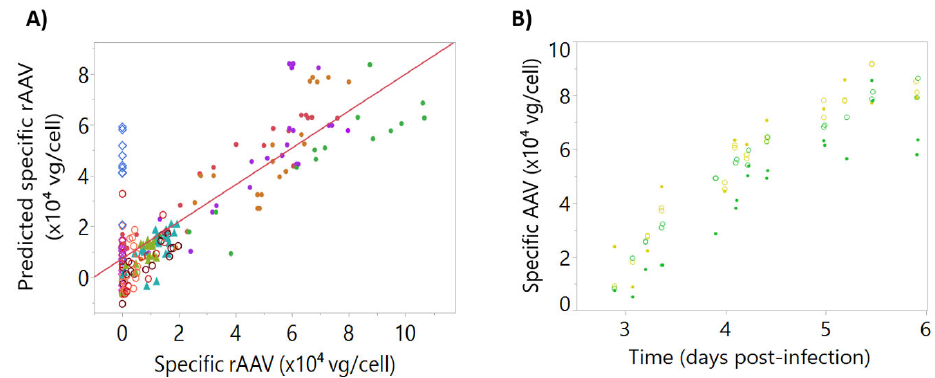
Figure 7. Calibration and testing data for intracellular specific recombinant adeno-associated virus (rAAV). Batches are represented by di ff erent colors. ( A ) Observed and predicted values for the dataset used for model calibration, R 2 = 0.71. Batches are represented by di ff erent colors, with filled triangles representing “cell density e ff ect” batches, empty diamonds representing “empty” batches, filled circles representing “standard” batches, and empty circles representing “blend” batches. ( B ) Intracellular specific rAAV time-course profiles for the testing set, Q 2 = 0.77. Reference data is represented by open circles and corresponding model-predicted values are shown as filled